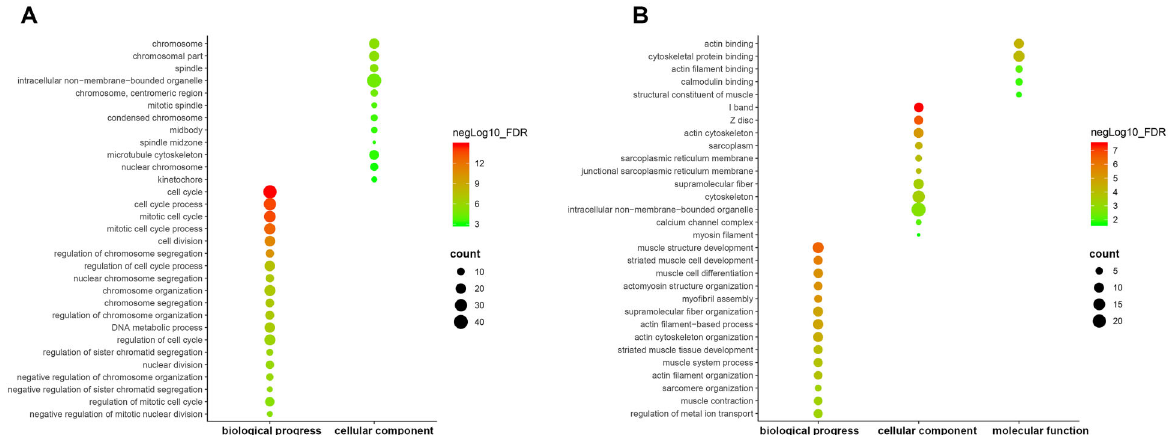
Figure 2. Gene Ontology (GO) functional annotation enrichment analysis of identi fi ed differentially expressed genes. X-axis represents GO terms, including biological progress, molecular function, and cellular component while Y-axis represents the names of GO terms. The green and red points represent high and low false discovery rate values, and the size of points indicates gene count. A , Enrichment result of upregulated genes; B , Enrichment result of downregulated genes.